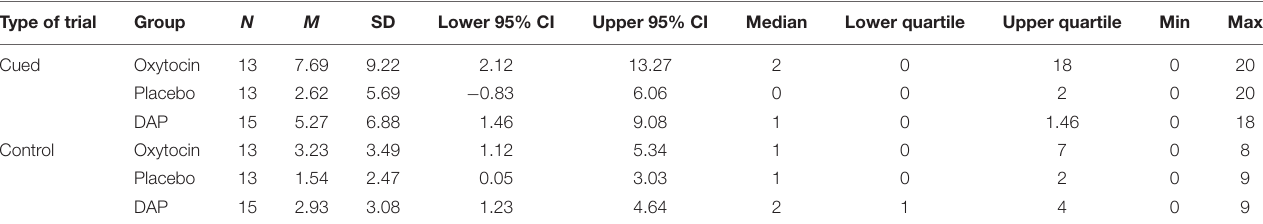
TABLE 4 | Mean and median number of times dogs in each treatment group did not make a choice in the cued trials (out of 20) and in the control trials (out of 10). Type of trial Group Cued